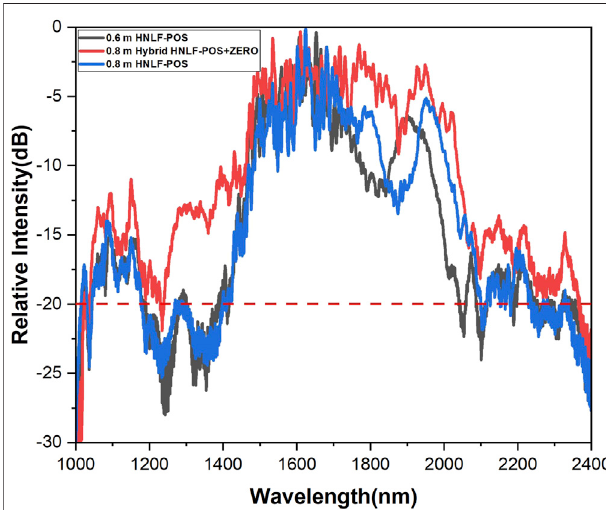
FIGURE 5 | The spectra generated in the HNLFs and the hybrid HNLF. The black lineand blue linerepresentthe 0.6 mand 0.8 m-long HNLFs with D = 4.205 ps/nm/km, respectively. The red line represents the hybrid HNLF consisting of two sections of HNLFs with D = 4.205 ps/nm/km (0.6 m) and zero dispersion (0.2